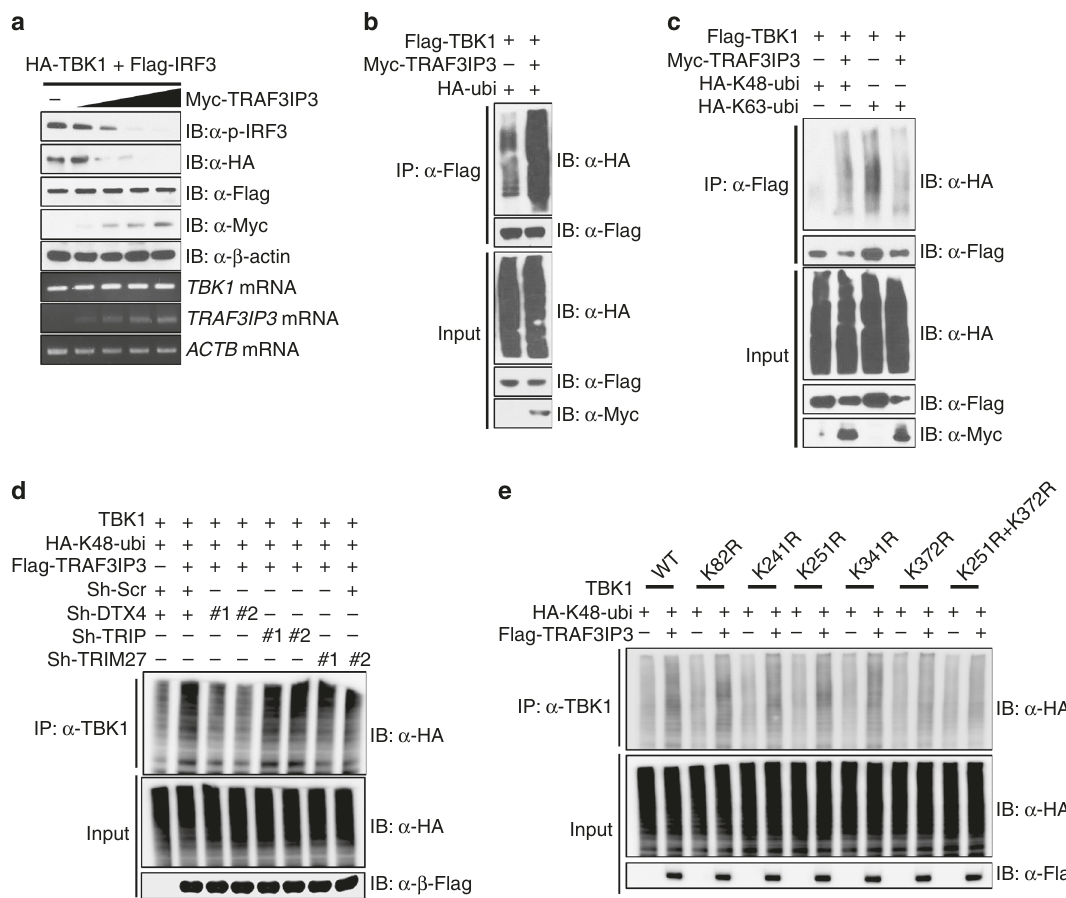
Fig. 6 TRAF3IP3 promotes K48-dependent ubiquitination of TBK1. a Immunoblotting (top) and RT-PCR (bottom) analyses using HEK293T transfected with HA-TBK1 and Flag-IRF3 and increasing doses of Myc-TRAF3IP3. b – e Coimmunoprecipitation and immunoblotting using HEK293T transfected with indicated vectors. Data are one representative of at least two independent experiments. Source data are provided as a Source Data fi